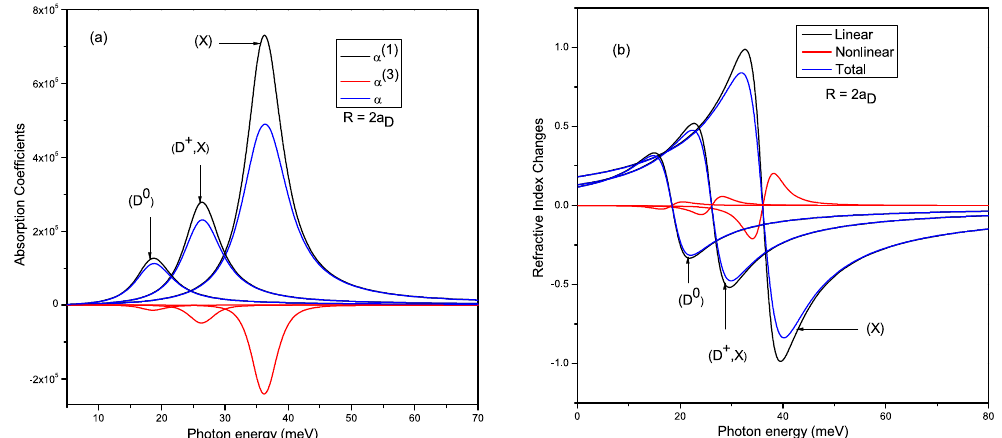
Figure 4. The absorption coefficients ( a ) and The refractive index changes ( b ) against incident photon energy ¯ h ω for exciton, ( D + , X ) complex and impurity and for 2 a D